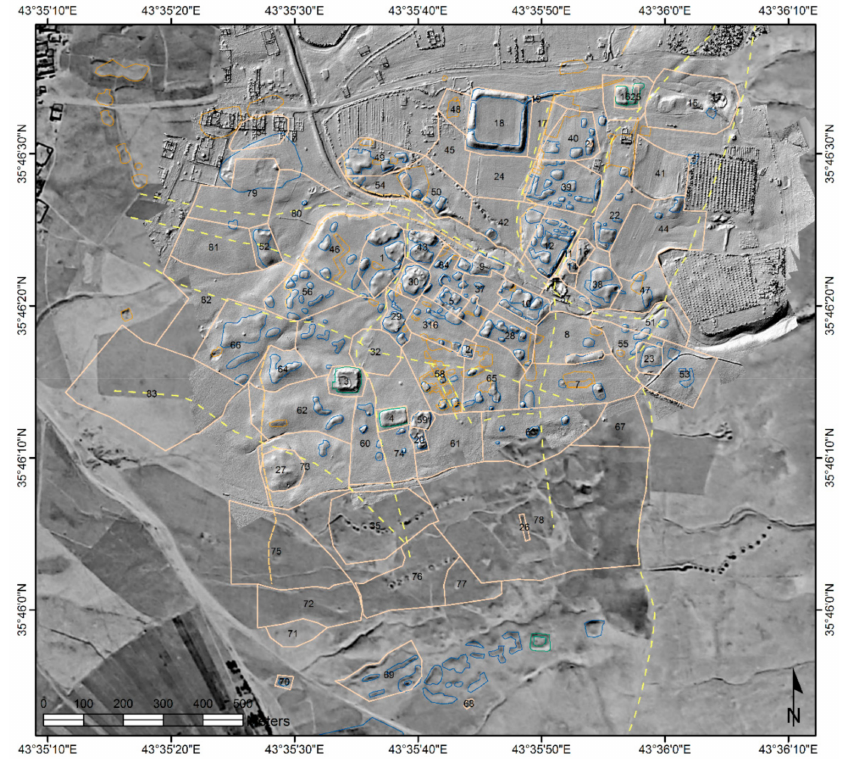
Figure 2. Kona Makhm¯ur, state of the Early Islamic site with the most important features: Traces of structures and water reservoirs (blue), fortified residences (qus ¯ ur; green), the original communication network (yellow), field survey polygons (pink). Satellite image HEXAGON, 1971, unmanned aerial system (UAV) hillshade 2015 (authors: Karel Nov á ˇcek, Lenka Starkov á